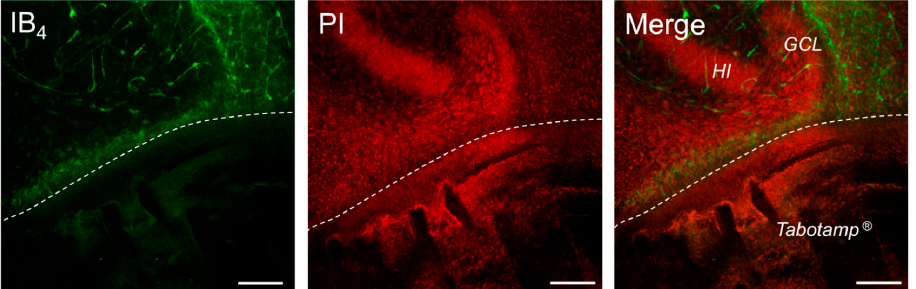
Figure 5 . Exemplary image of an OHSC after half-side Tabotamp ® treatment. Damaged neuronal cells were stained with PI (red) and microglia cells as well as vascular structures with IB 4 (green). The Tabotamp ® covered area was clearly distinguished (below the dotted line) from the granule cell layer (GCL) of the DG and hilus region (HI), which was still well preserved above. Notably, a clearly reduced number of IB 4 positive cells is visible, while at the border a distinct increase of microglia cells could be observed. Bar = 100 µ